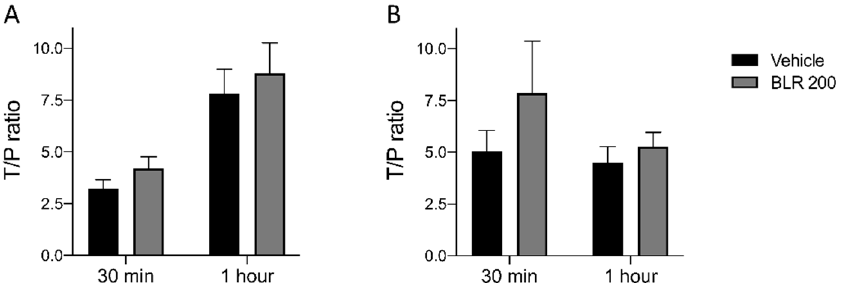
Figure 5. Effect of BLR200 on gemcitabine distribution. Gemcitabine ( A ) and the dFdU metabolite ( B ) were measured by HPLC–MS analysis in plasma and tumors of mice bearing FC1199 orthotopic tumors, treated or not with BLR200. Data are the ratio between tumor (T) and plasma (P) concentration, 30 min and 1 h after gemcitabine administration (mean ± SEM, n = 4).